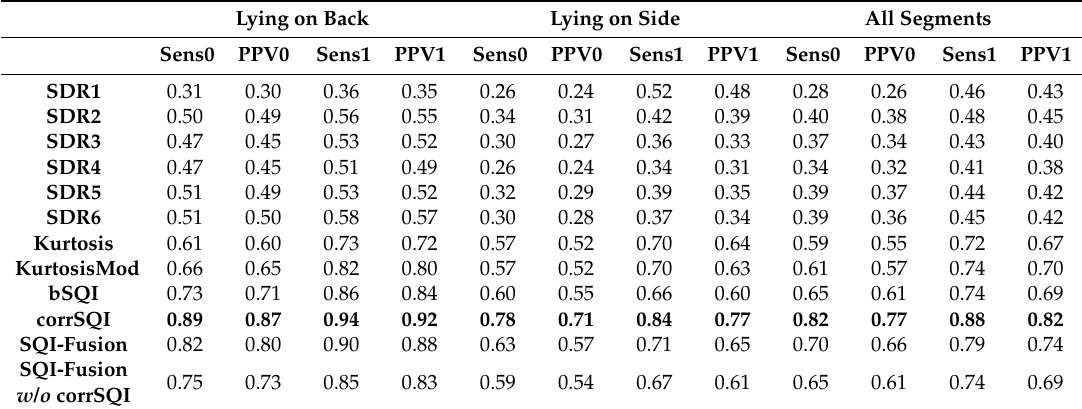
0.82 0.77 0.88 0.82